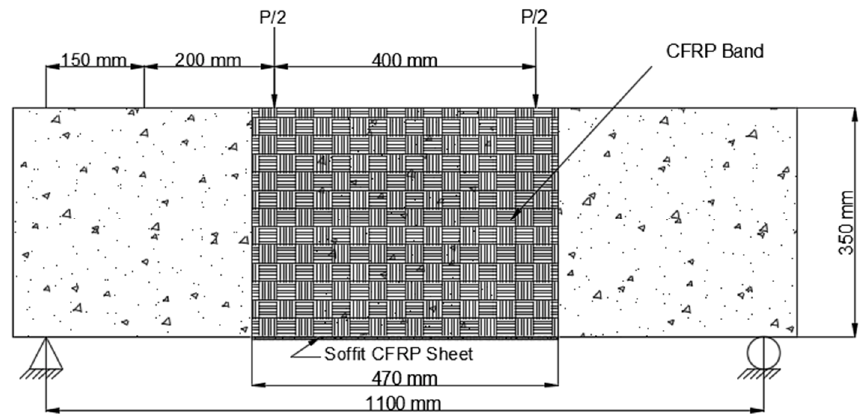
Figure 13. Placement of CFRP on beam Scheme 6 (B6).